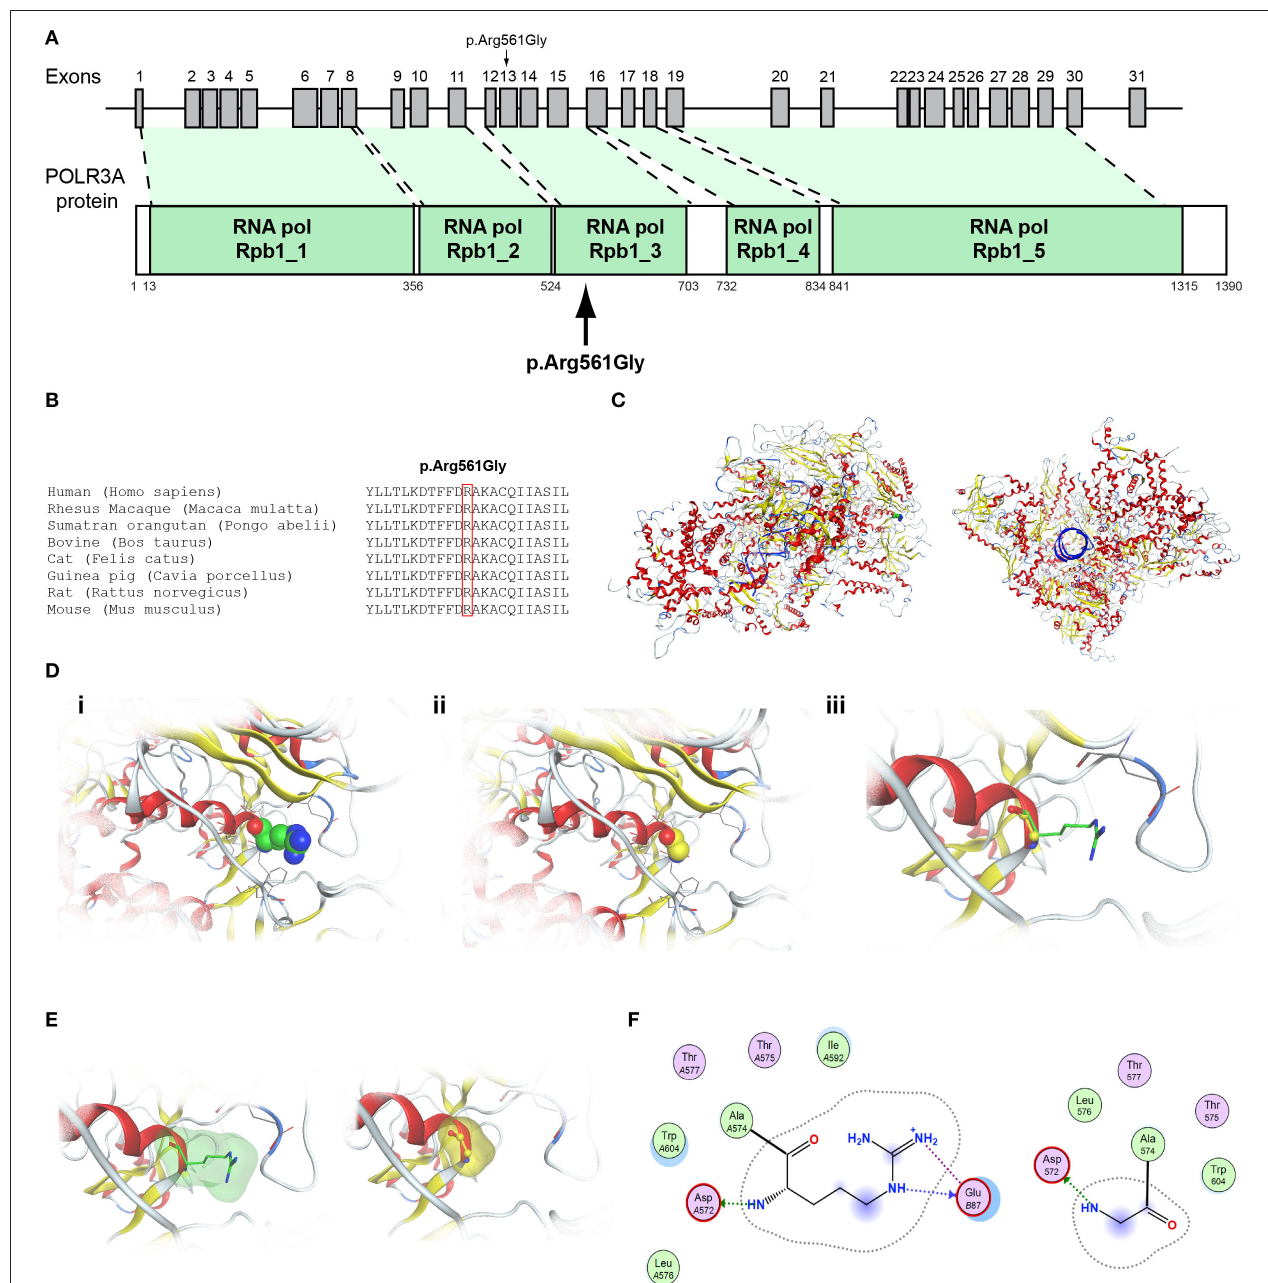
FIGURE 6 | Identification of the p.Arg561Gly POLR3A variant. (A) Schematic representation of the POLR3A gene and protein. The p.Arg561Gly POLR3A variant is indicated with arrows. (B) Multiple sequence alignment of the amino acid at position 561 of the POLR3A protein from various species. The conserved arginine amino acid at position 561 is indicated by red color. (C) The homology model for POLR3A. (D) Design of the wild type (i) and mutant model (ii) of POLR3A. (iii) Wild type and mutant models superposed. (E) Electrostatic surface calculated and drawn for the wild type and mutant models. (F) 2D interaction diagram for wild type and mutant